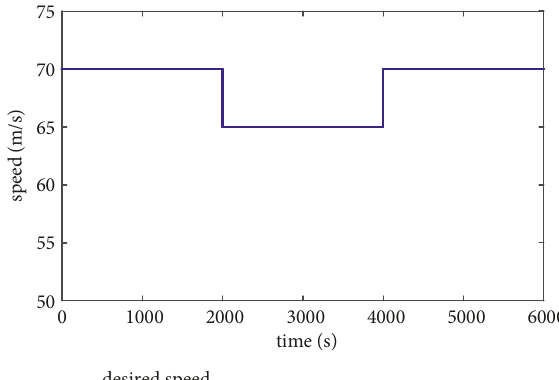
Figure 5: The desired speed curve, which is divided into three intervals. The desired speeds within [0, 2000] s, [2000, 4000] s, and [4000, 6000] s are, respectively, 70m/s, 65m/s, and